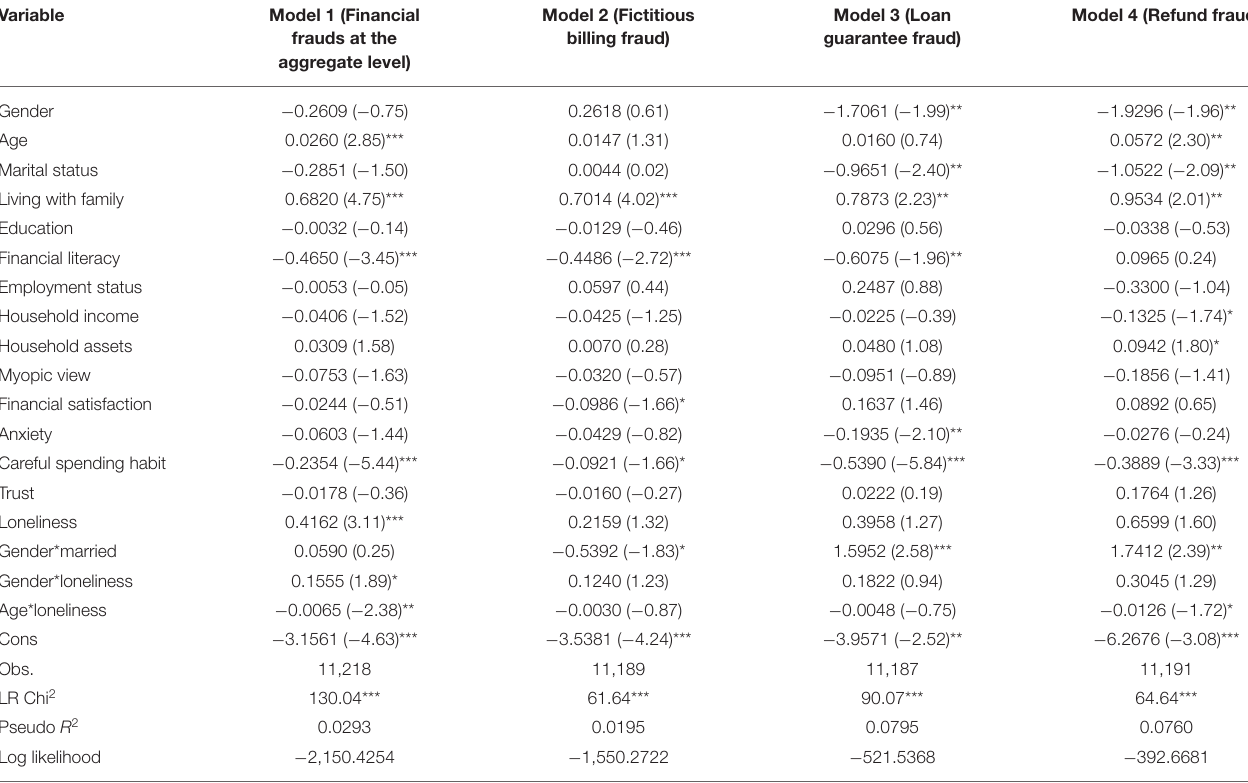
TABLE 5 | Regression results using interaction